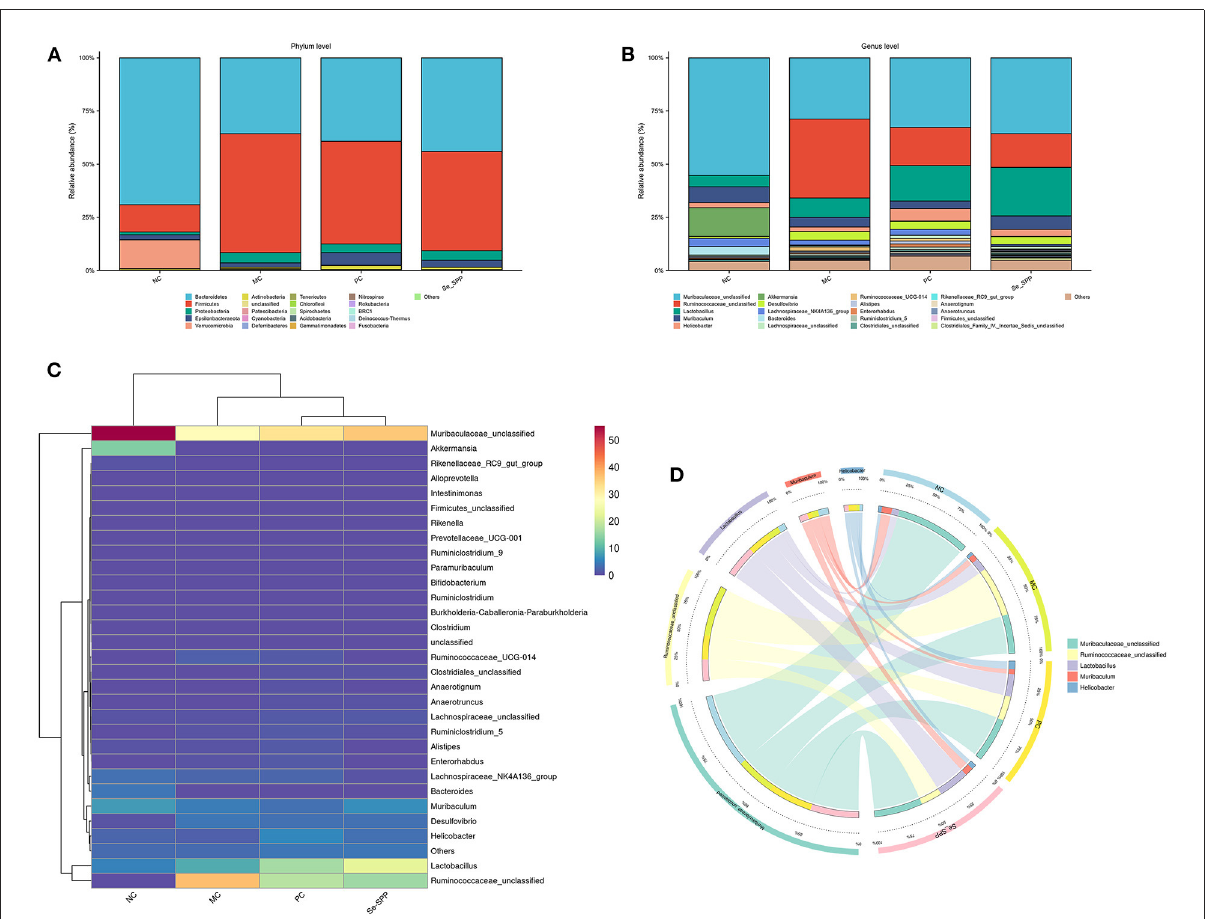
FIGURE4 Se-SPP reshapes Cd-induced gut microbiota in mice. Relative abundance at the phylum level (A) , relative abundance at the genus level (B) , difference analysis of gut microbiota composition at the genus level (C) , and community heatmap analysis at the genus level (D) . NC, normal control; MC, model control; PC, positive control; Se-SPP, selenium-containing polysaccharides from Spirulina platensis . Data are expressed as mean ± SEM ( n =